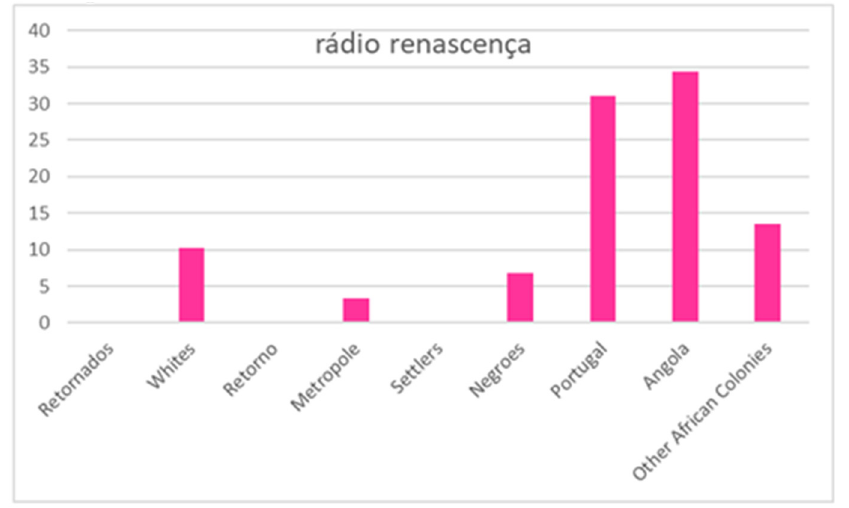
Figure 16. Most frequent words in the text “60 anos depois, ‘continua a ser um desconforto falar sobre a Guerra do Ultramar’”. Source: Rádio Renascença (2021) [14].